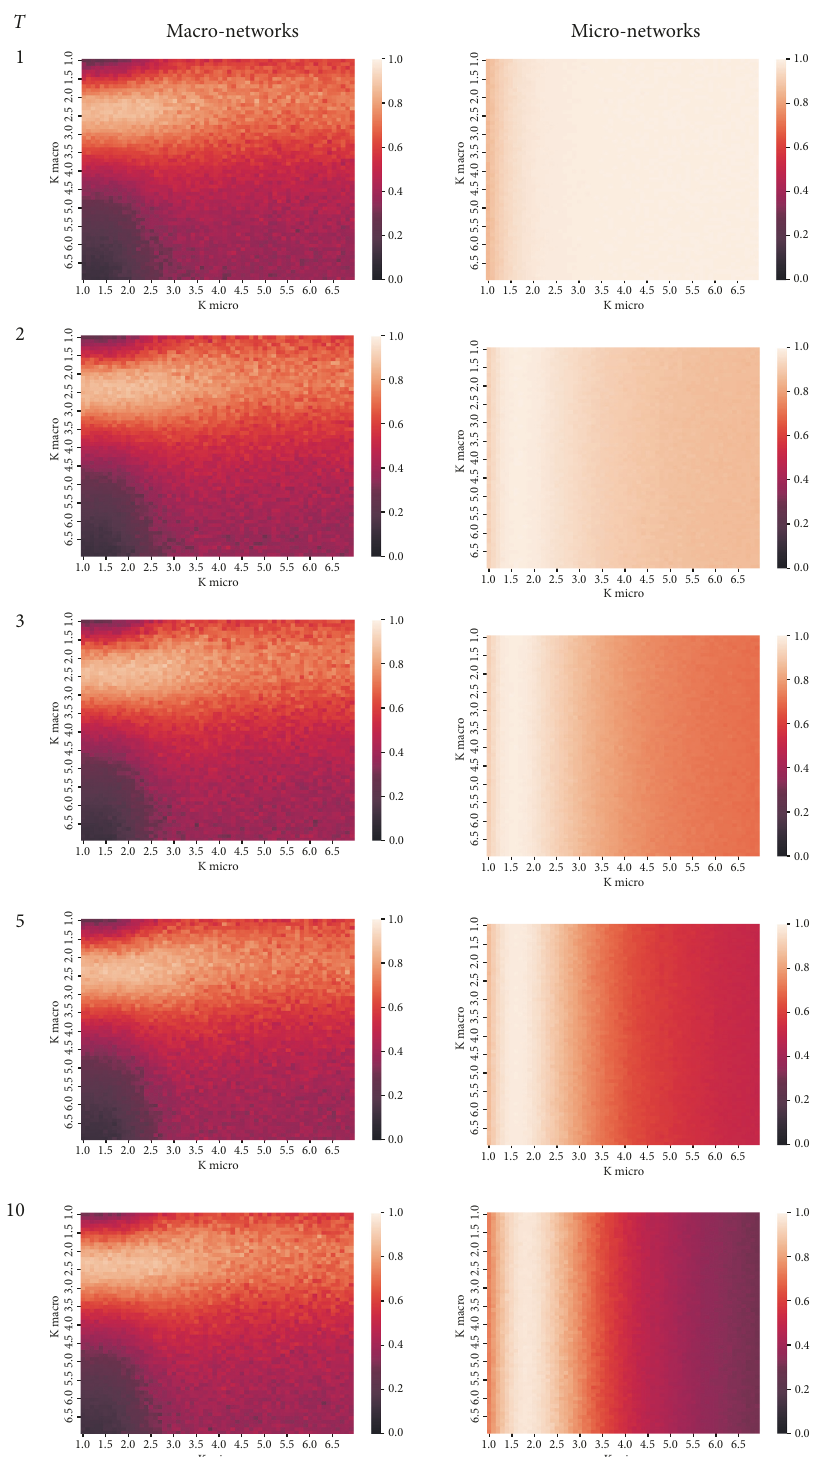
Figure 14: Heat maps of the complexity of micro- and